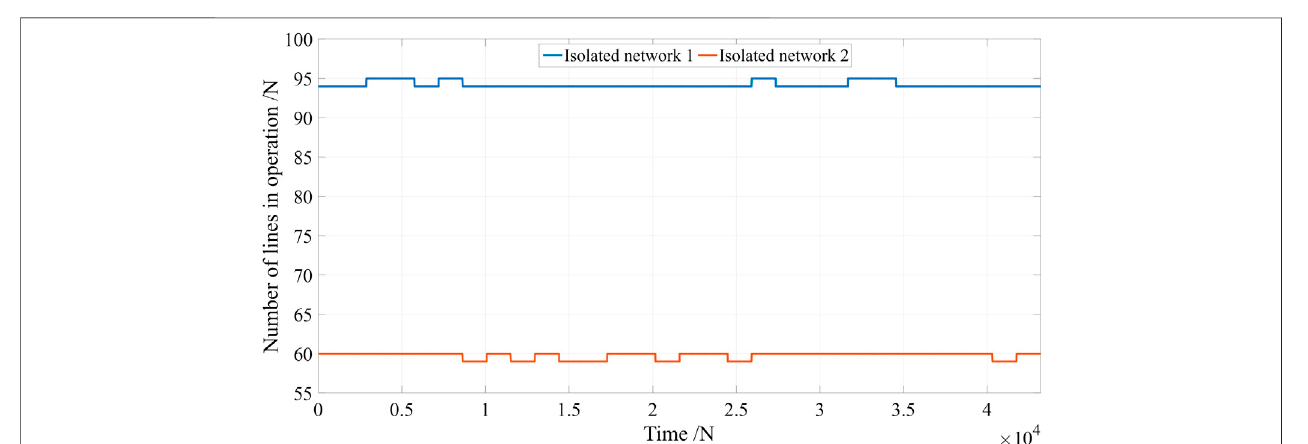
FIGURE 12 | Changes in the number of lines in operation on the isolated networks in the time series.